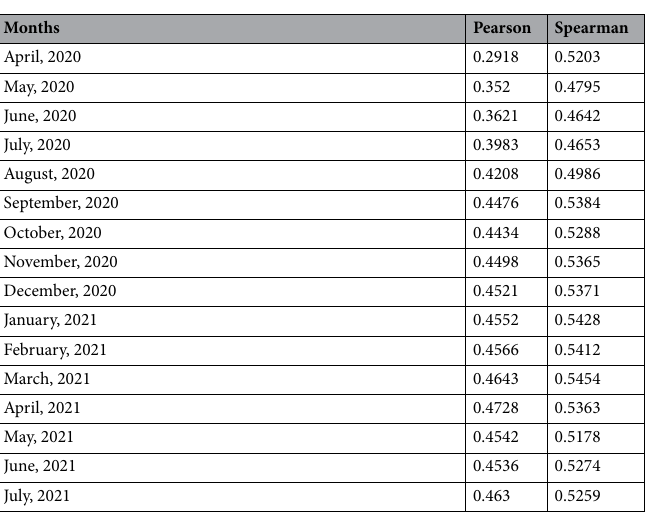
Table 1. Univariate analysis between total COVID-19 cases/million populations of a country and other metabolic parameters.